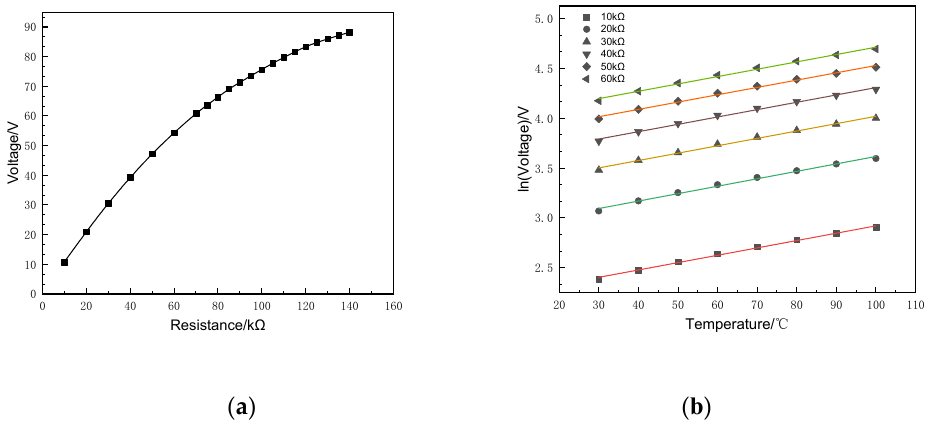
Figure 7. Output voltage at different temperatures. ( a ) At 20 °C; ( b ) At temperature gradient.